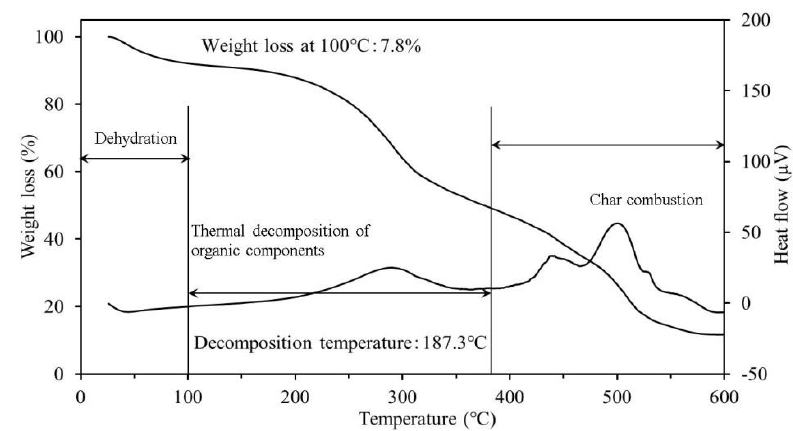
Figure 7. TG-DTA results for the fishmeal sample.